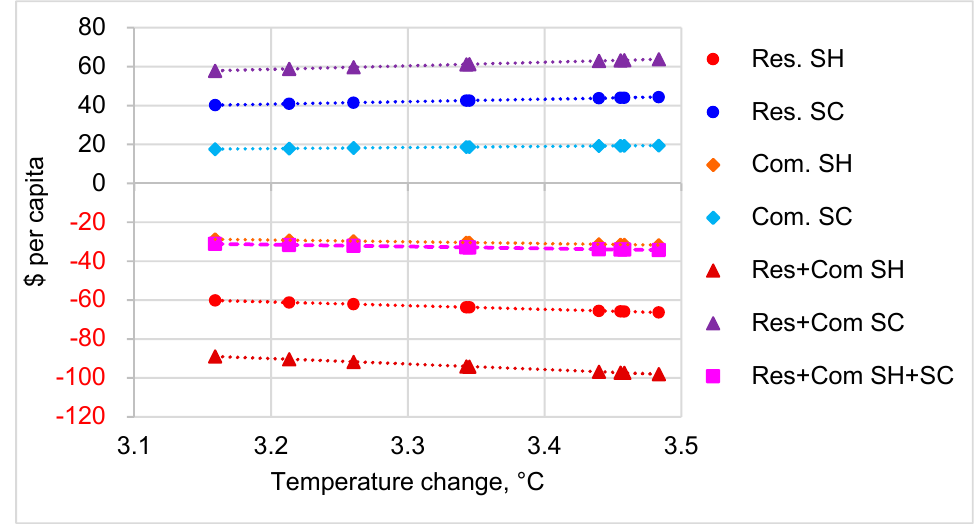
Figure 8. Residential and commercial buildings per capita space heating and space cooling expenditure change versus temperature change at 3 ◦ C GMST increase for the nine census divisions.